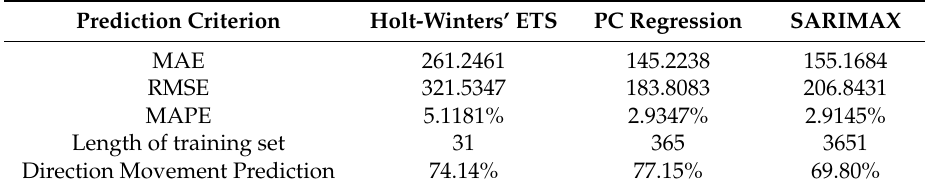
Figure 21. Forecast accuracy comparison for May 2014 for the Greek electricity market.